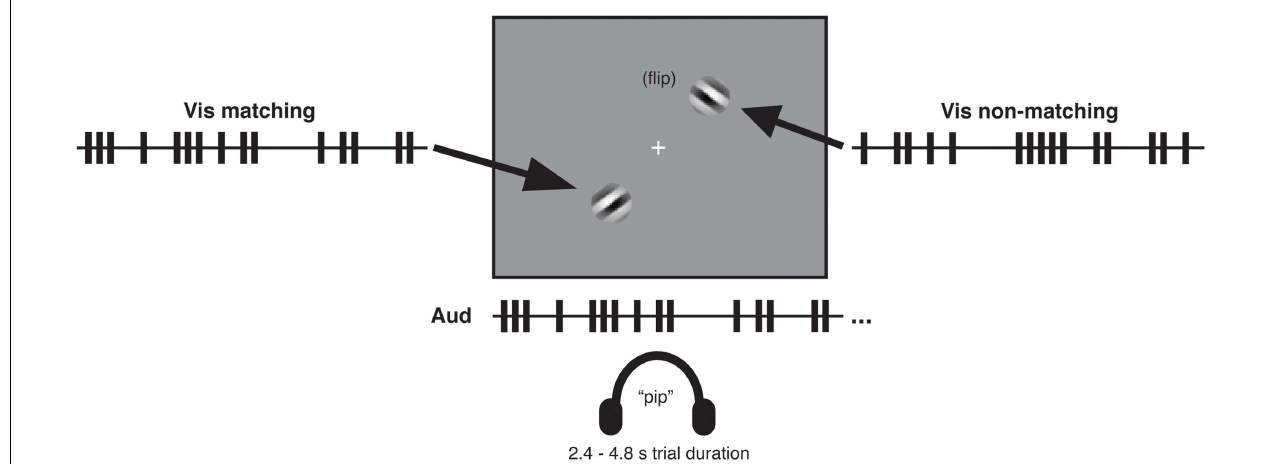
visual stream (the non-matching stream) had a different temporal pattern of flips (see main text). After each trial (which lasted 2.4–4.8s depending on the experiment and condition), participants reported which of the two visual streams had matched the auditory stream in temporal pattern. Example timelines (truncated here for brevity) of auditory and visual streams show auditory events (tone pips) and visual events (orientation flips) as trains of vertical bars. A key aspect of the procedure was that for all lagged conditions, the proportion of (coincidentally) synchronous audio-visual events was equated, see main